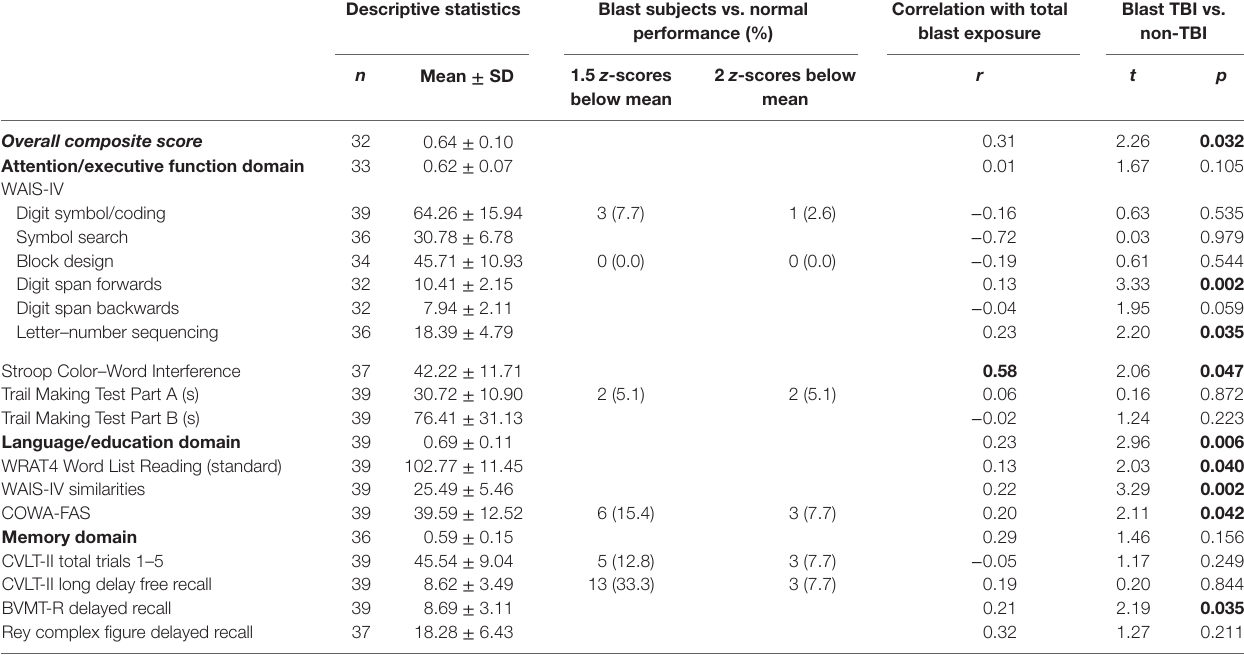
TaBle 4 | neuropsychological testing